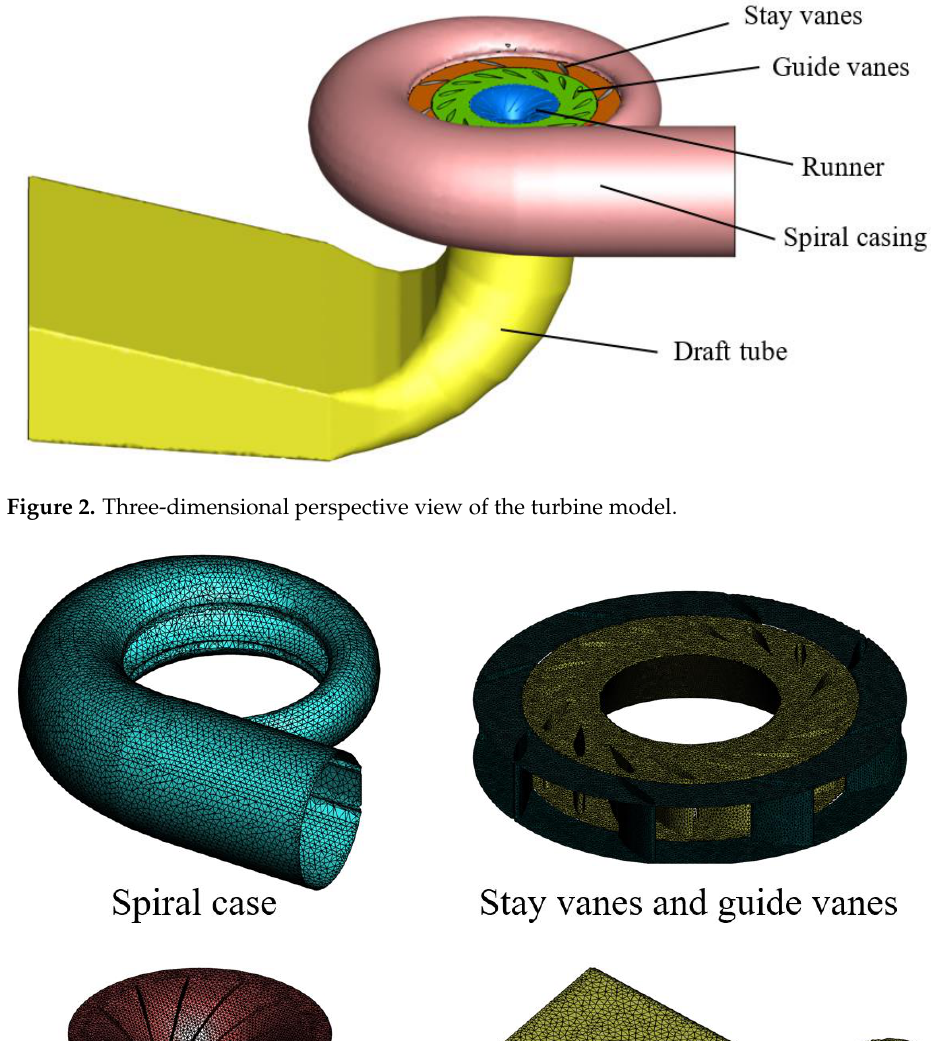
Figure 2. Three-dimensional perspective view of the turbine model.